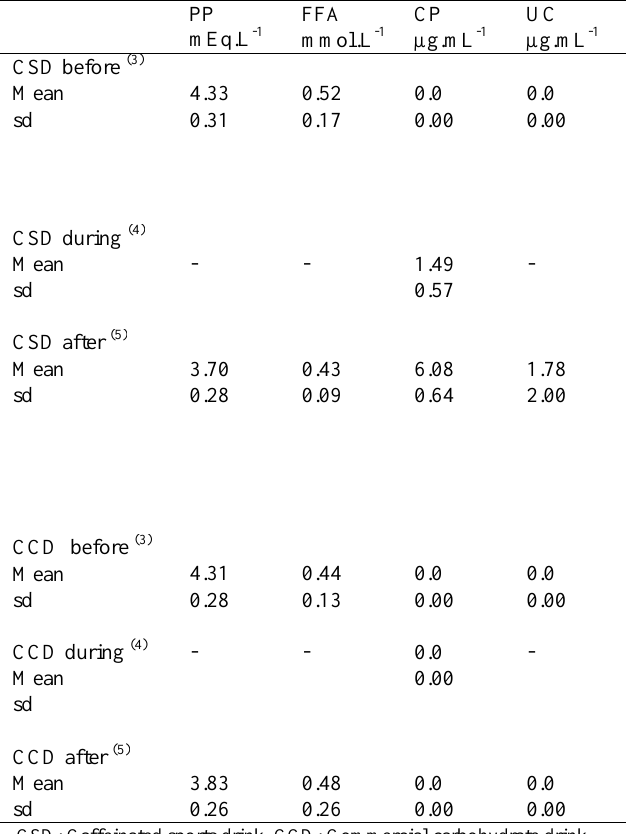
Table 2. Biochemical parameters of